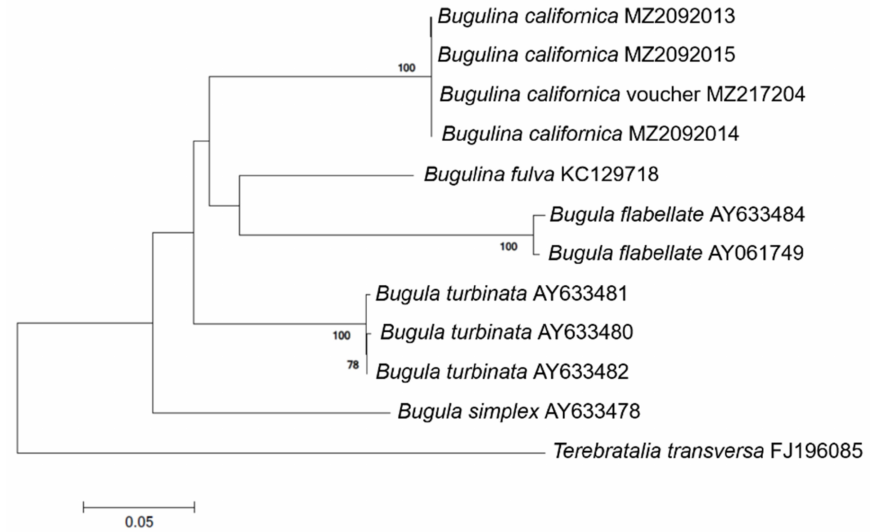
Figure 2. Phylogenetic tree of B. californica and related species constructed using 507 bp mt-COI sequences, excluding primers. GenBank accession numbers of the species are provided. Bootstrap resampling values were supported at ≥ 70. The scale bar indicates the genetic